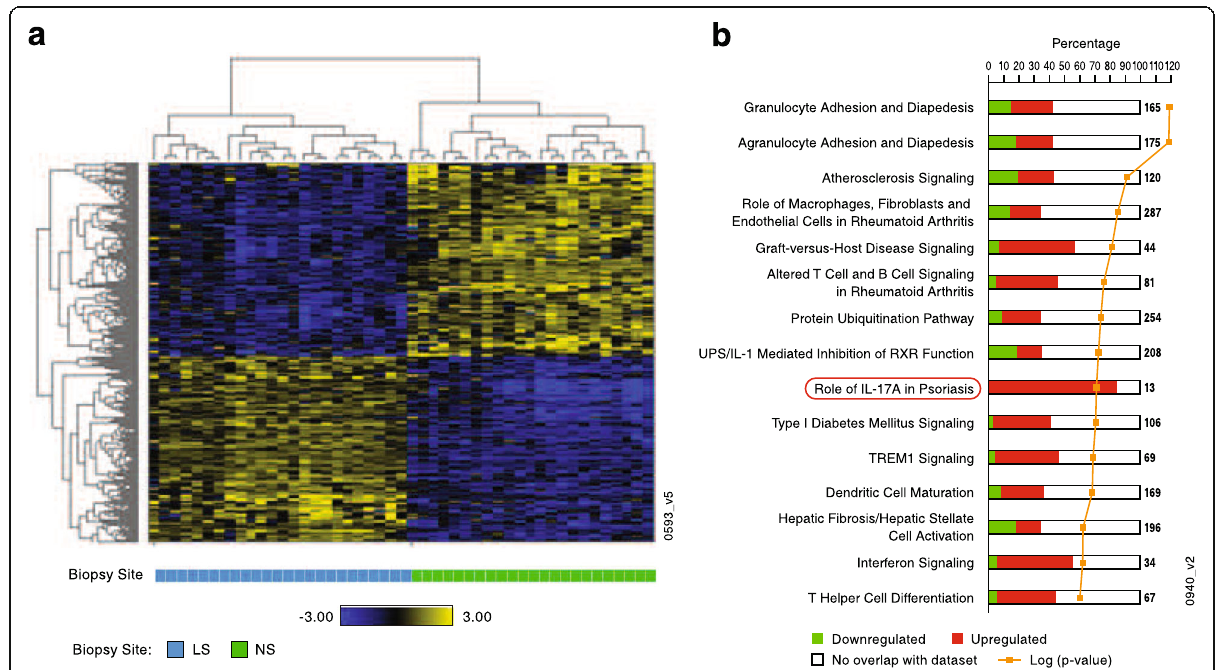
Fig. 3 Moderate psoriasis signature. ( a ) Hierarchical clustering diagram of a moderate psoriasis signature generated from biopsies taken from lesional skin (LS; blue bar ) and nonlesional skin (NS; green bar at the bottom) of the same patients at baseline; genes are represented as rows and samples as columns. Upregulated genes are shown in yellow and downregulated in blue ; ( b ) enrichment of ingenuity pathways by moderate psoriasis gene signature. The stacked bar chart displays the number of up-regulated ( red ) and down-regulated ( green ) genes in each Ingenuity Canonical Pathway. The pathways are ranked by the p -value of a Fisher exact test from top to bottom ( orange line ; p -value listed in Additional file